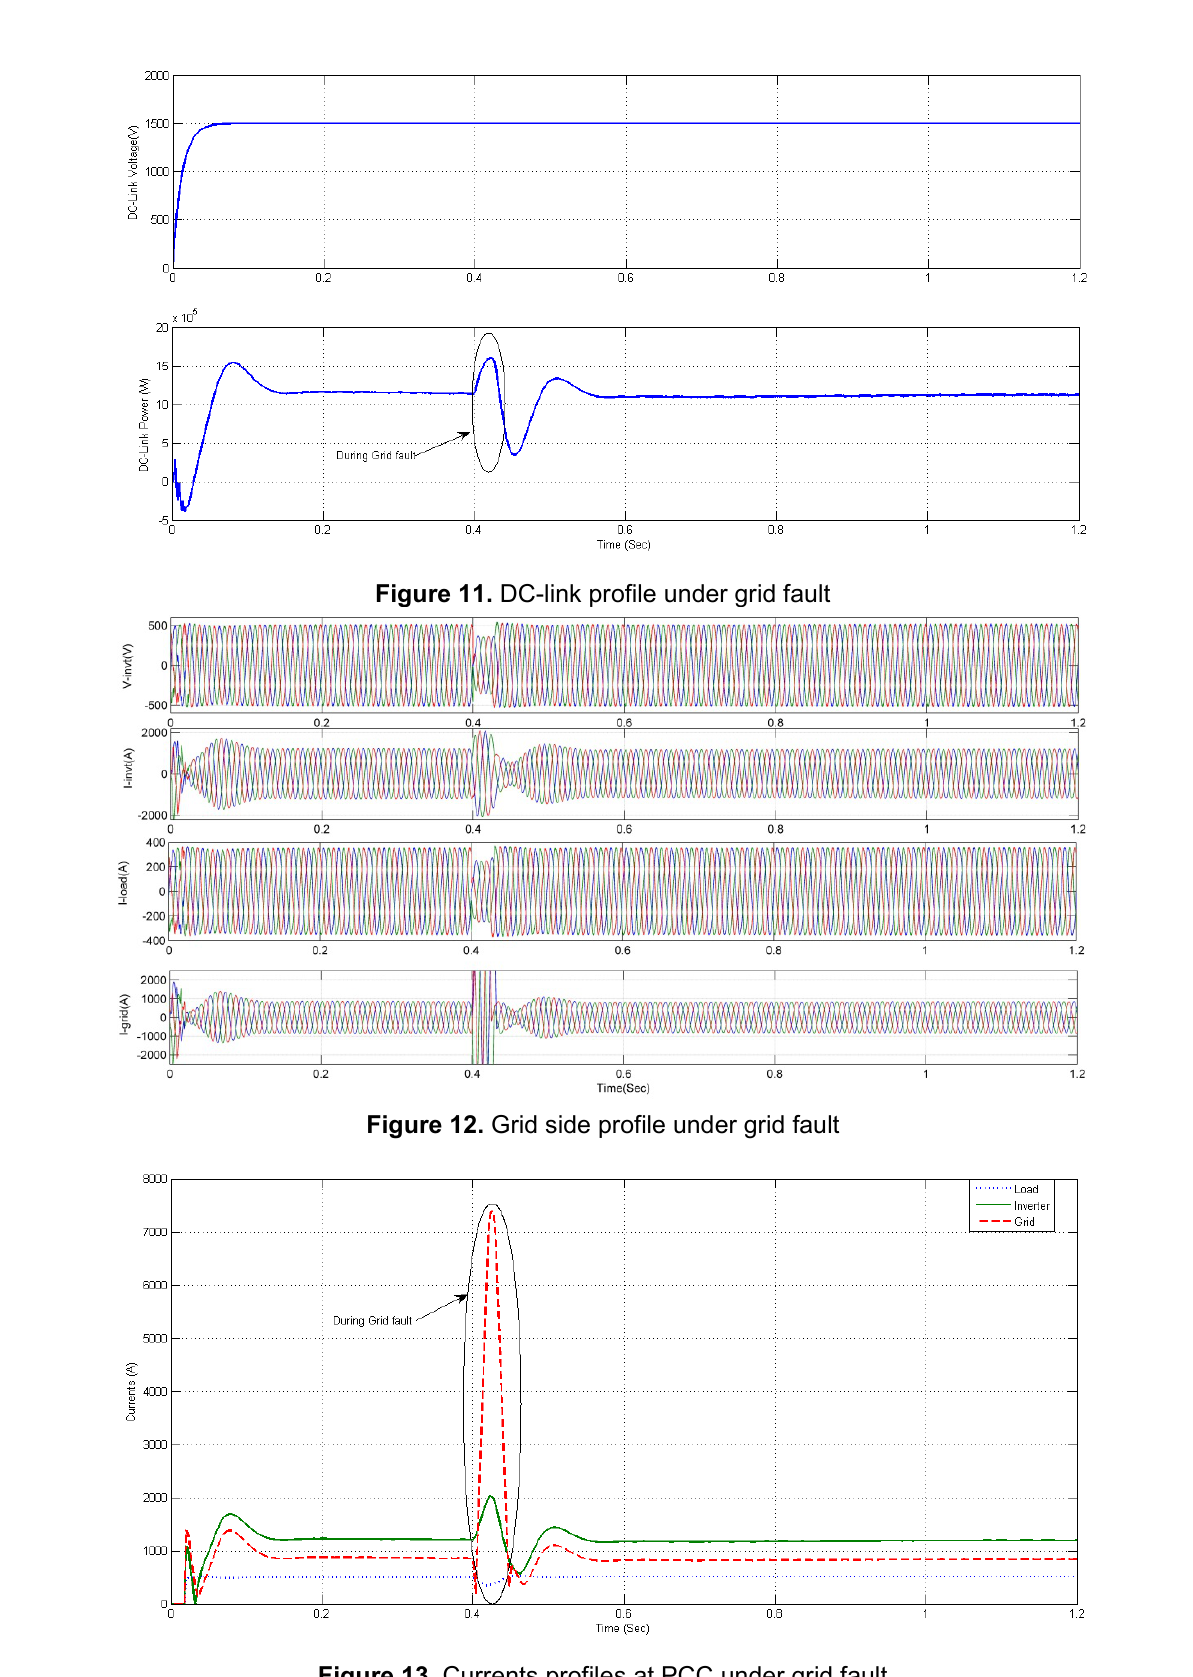
Figure 13. Currents profiles at PCC under grid